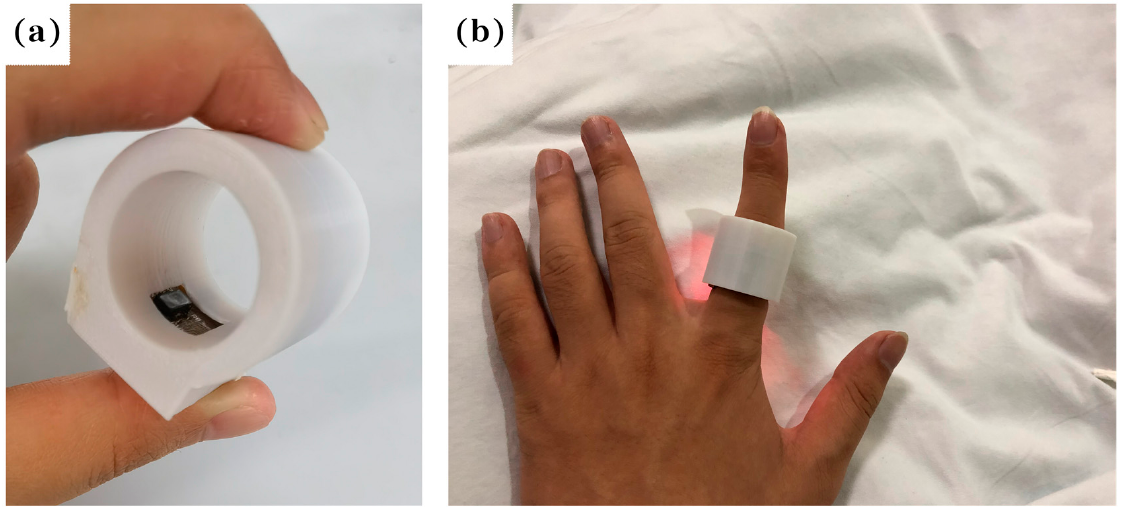
Figure 4. The photo of the fabricated smart ring ( a ); human hand with the smart ring ( b ).